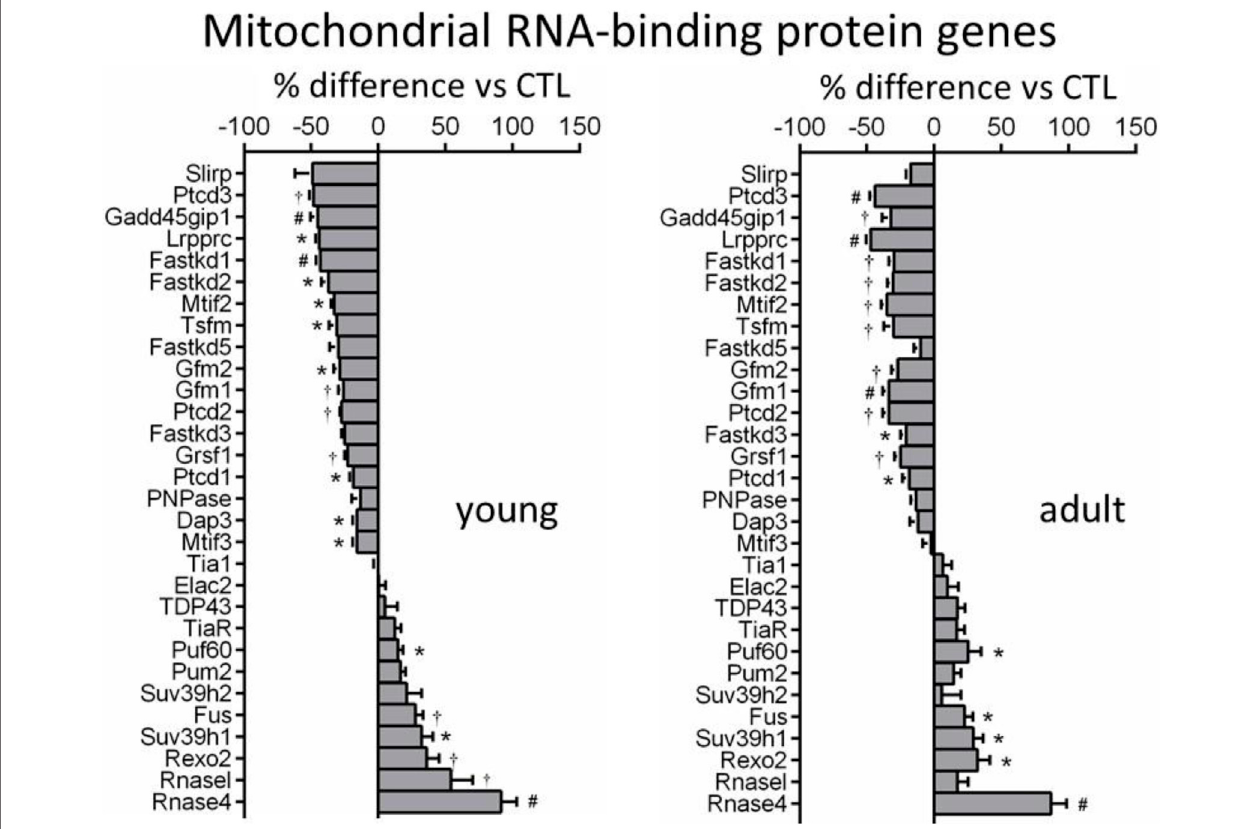
FIGURE 4 | Changes in expression of genes coding mitochondrial RNA-binding proteins (MRBPs). Bar graphs showing expression levels of MRBP genes in DCM hearts of both age-groups relative to age-matched controls. * p < 0.05, † p < 0.01, # p < 0.001 vs.